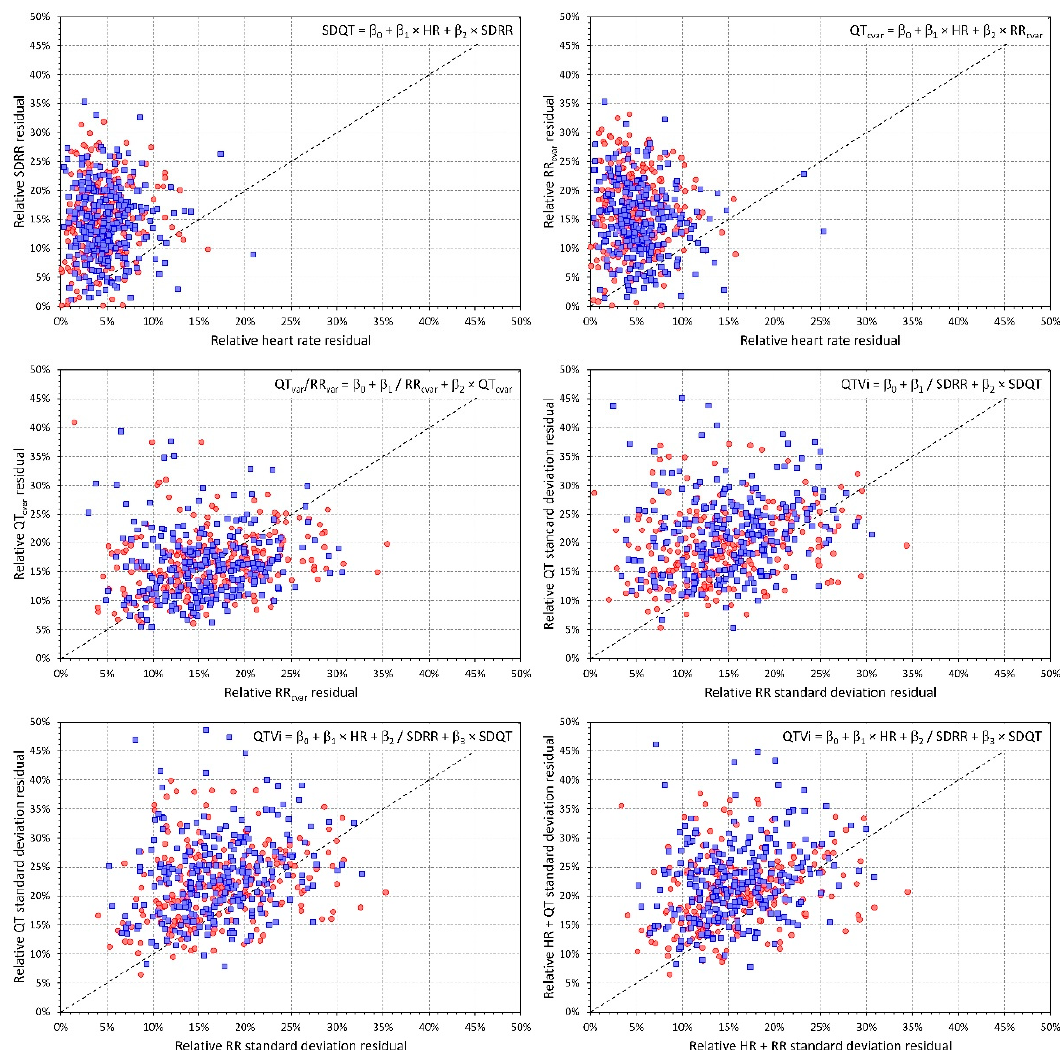
Figure 6. Sequential analysis of the regression variance. Results of the sequential analysis of the regression variance (see the text for details). Each panel corresponds to a given linear regression estimate (see the formulas at the top right of the panels) and shows the relative residuals, that is the proportions (e A − e AB ) / e A or (e AB − e ABC ) / e AB as explained in the text. Scatter diagrams in the separate panels show the relationship between relative residuals of predictors used in the multivariable regression. The labels of the axes have the form “Relative A residuals” or “Relative A + B residuals” meaning the proportions (e A − e AB ) / e A or (e AB − e ABC ) / e AB . In each panel the dashed line shows the line of identity. In each panel, the red circles and blue squares correspond to female and male subjects, respectively (note that the multivariable linear regressions and their residuals regressions were evaluated in each subject separately using all the ECGs available for the given